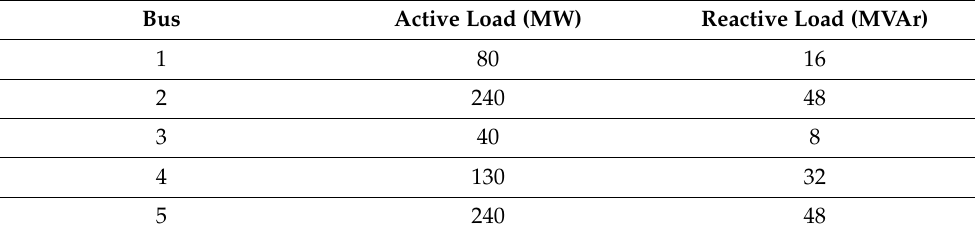
Table 2. Line characteristics of 6-bus network [47].